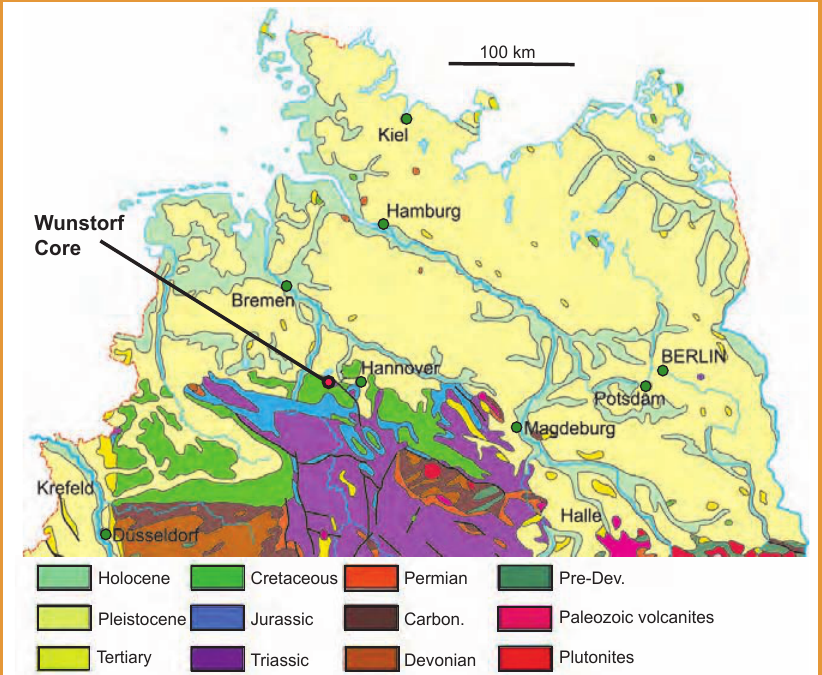
Figure 1. Geology of Northern Germany with location of the Wunstorf bore